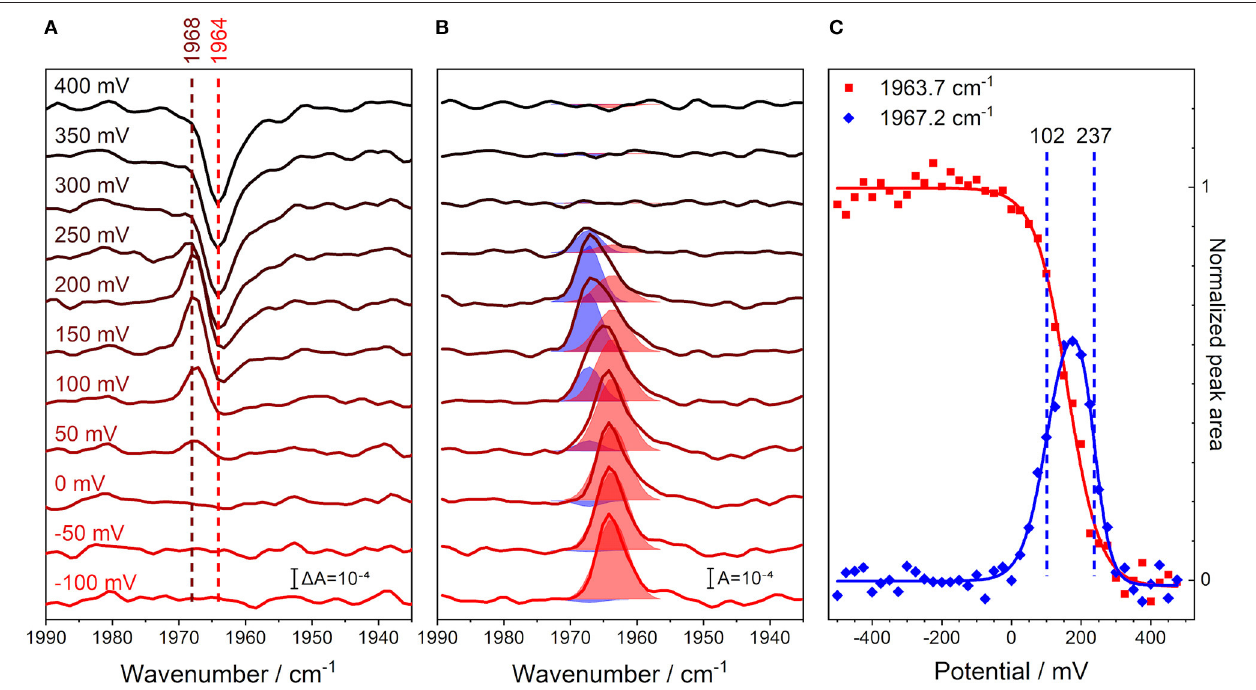
FIGURE 3 | Monitoring the C ≡ O stretching band of iron-bound carbon monoxide in C c O and its unbinding from the enzyme through a potentiometric titration in H 2 O buffer. All potential values are given against the Ag/AgCl reference electrode. (A) Potential-resolved difference spectra of oxidized-reduced C c O from − 100 (red) to + 400mV (black), background taken at − 500mV. The number of spectra is cut from the full potential range and reduced for clarity to one every 50mV step. The peak positions for the initial shift of the CO band (brown), as well as the original CO peak position (red), are marked with dashed lines. (B) Potential-resolved absolute spectra of reduced-oxidized C c O obtained by subtracting the average of 3 spectra under oxidizing conditions ( + 500 to + 550mV). The spectra are indicative of the same potentials as in the left panel. The fits to the two CO bands are shown as shaded areas. The fits were obtained by fitting Voigtians with 20% Lorentzian and 80% Gaussian to all the spectra in this data set. Once the spectral fit converged, determining the peak positions and FWHMs, these parameters were maintained for all spectra, while the peaks’ amplitudes were allowed to vary. (C) Full potential traces of the C ≡ O stretching peaks’ integrals; steps of 25mV from − 500 to + 550mV. These data are proportional to the concentration profiles of the species. The peak areas at 1963.7 (red) and 1967.2 cm − 1 (blue) are taken directly from the fit parameters calculated from the central panel and are shown as scatter plots. The sigmoidal fits of the peak area traces are shown as solid lines. The calculated midpoint potentials of the 1967.2 cm − 1 peak fit function are displayed as dashed vertical